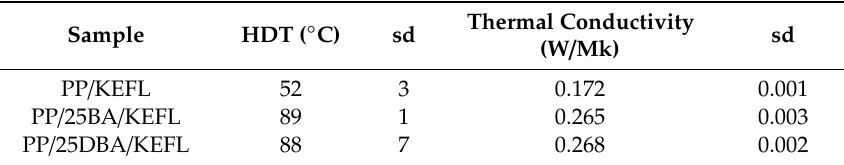
Table 6. HDT and thermal conductivity of PP composites.